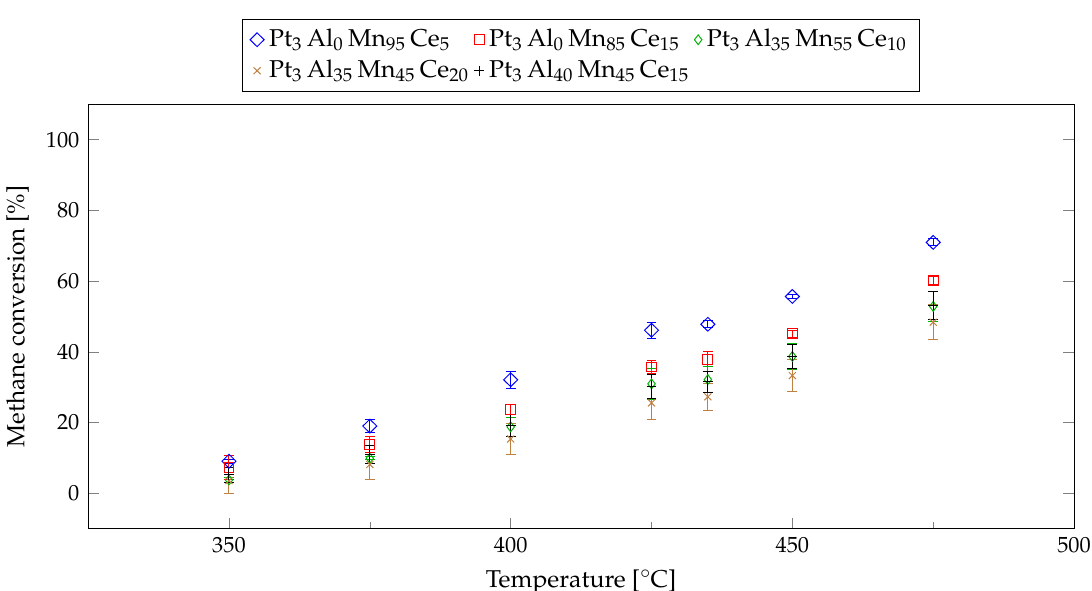
Figure 13. Methane conversion at different temperatures for samples from from composition range Pt 3 Al a Mn b Ce c from Table 2. 12.5vol.% H 2 O, 12.5vol.% CO 2 , 9.0vol.% O 2 , 0.25vol.% CH 4 , 0.055vol.% CO, 0.012vol.% NO, 0.004vol.% NO 2 , 0.001vol.% SO 2 , balance He, WHSV = 36,000mL/ ( gh ) . Error bars represent standard deviation ( n = 3) as given by Equation 2.